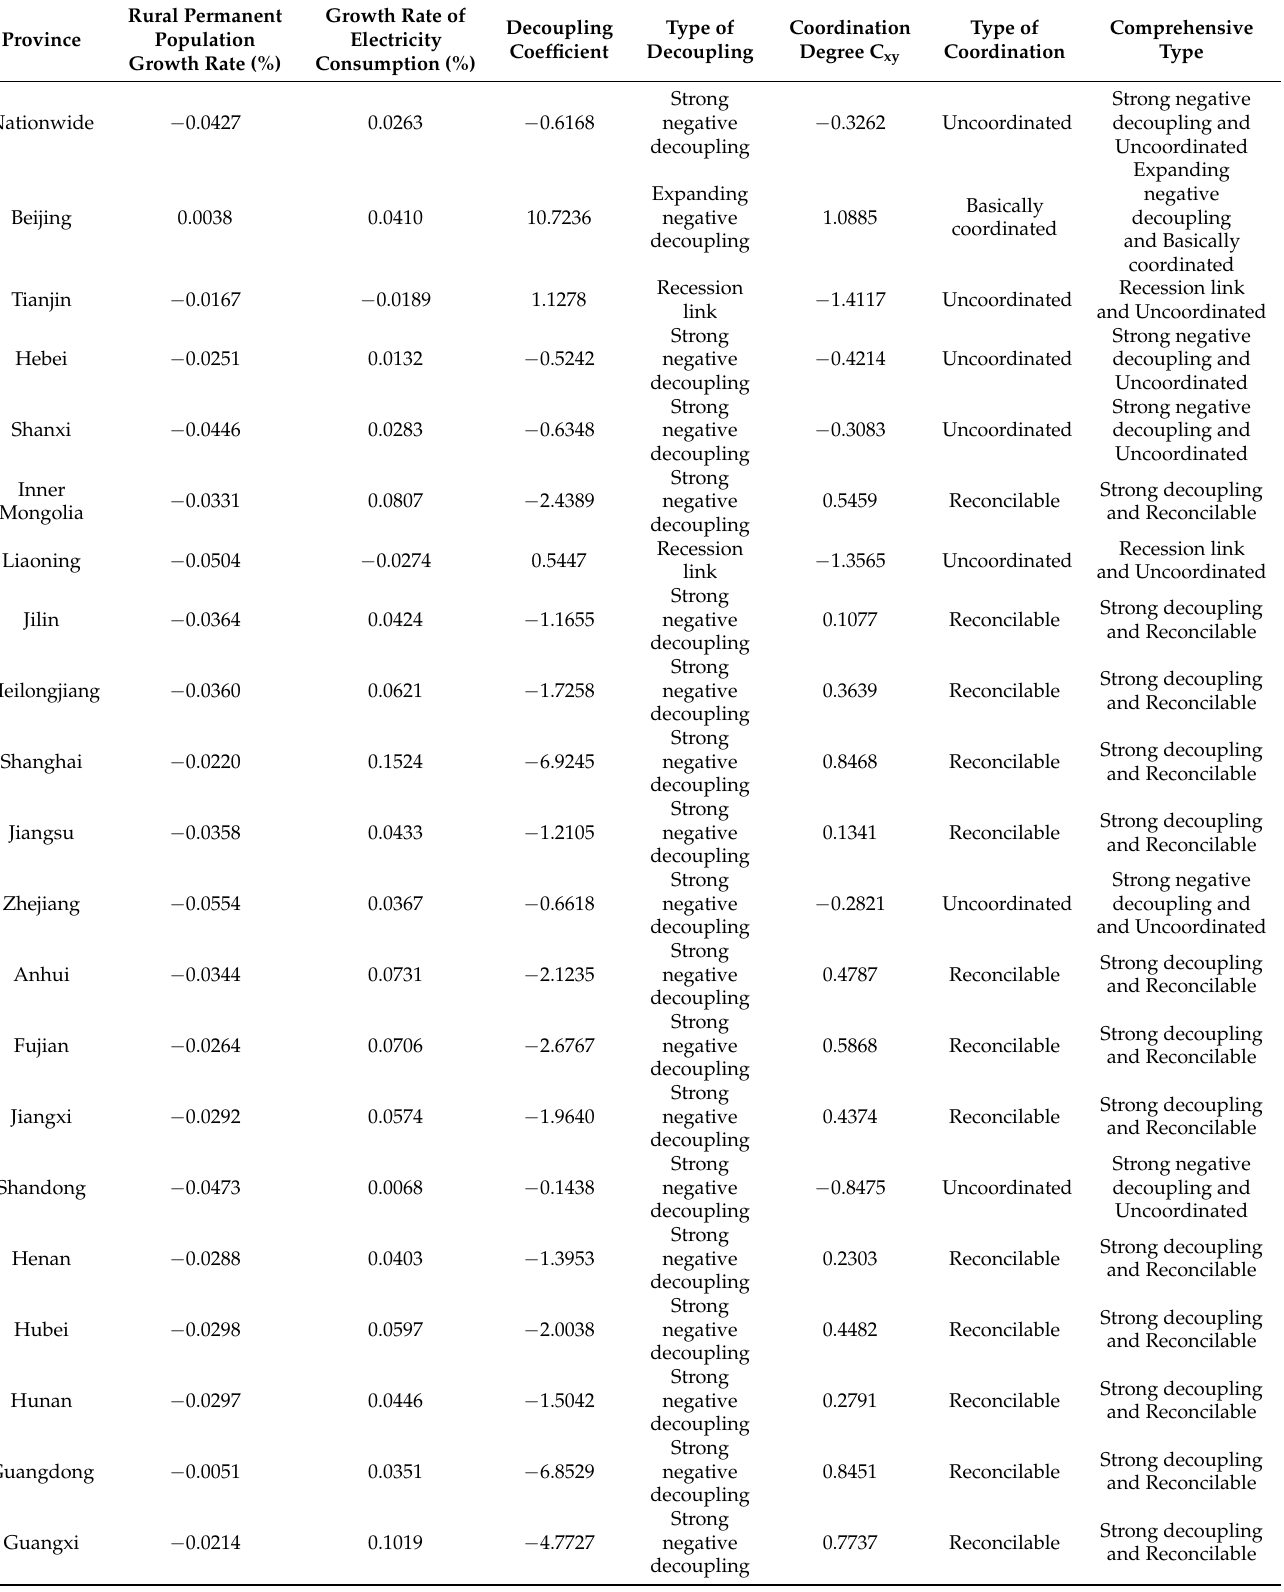
Table 3. Decoupling coefficient and coordination between rural electricity consumption and rural